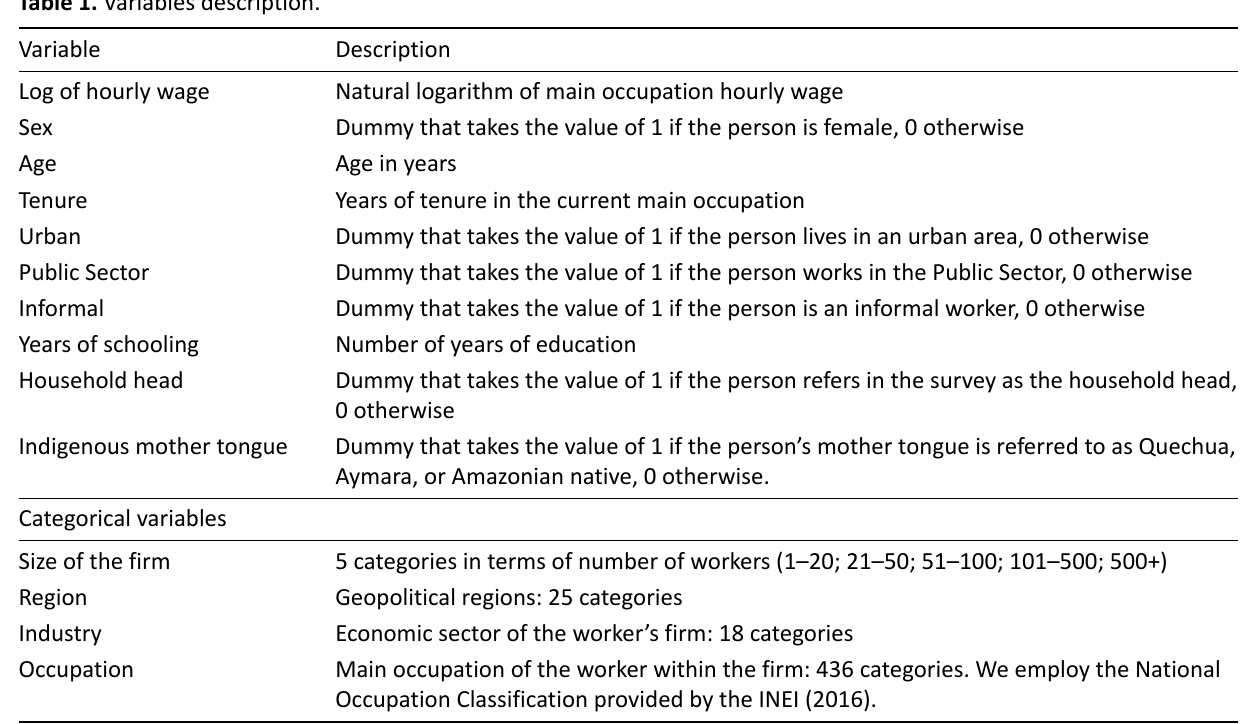
Figure 1 graphs the evolution of the raw, unexplained, and explained gender wage gap between 2007 and